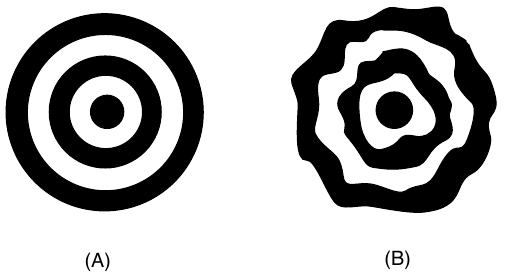
Figure 6 . (A) The background con(cid:12)guration consisting of annuli or rings. (B) A sample classical deformation around this